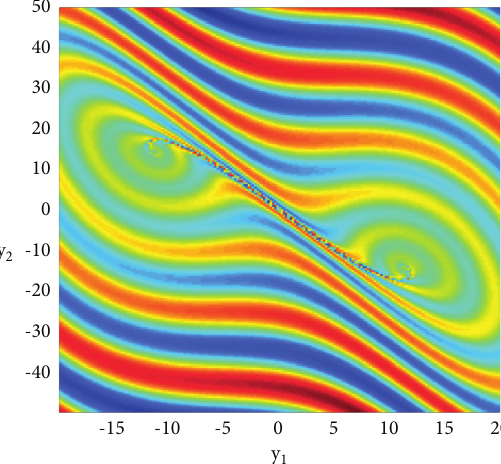
Figure 4: A cross section for y